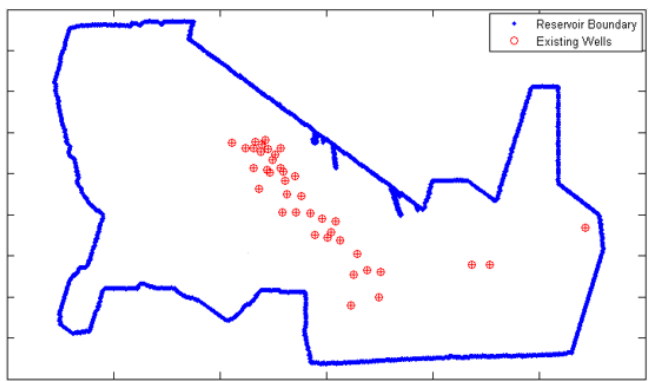
Figure 11. Reservoir boundaries and existing well locations of the reservoir in Wilcox formation.